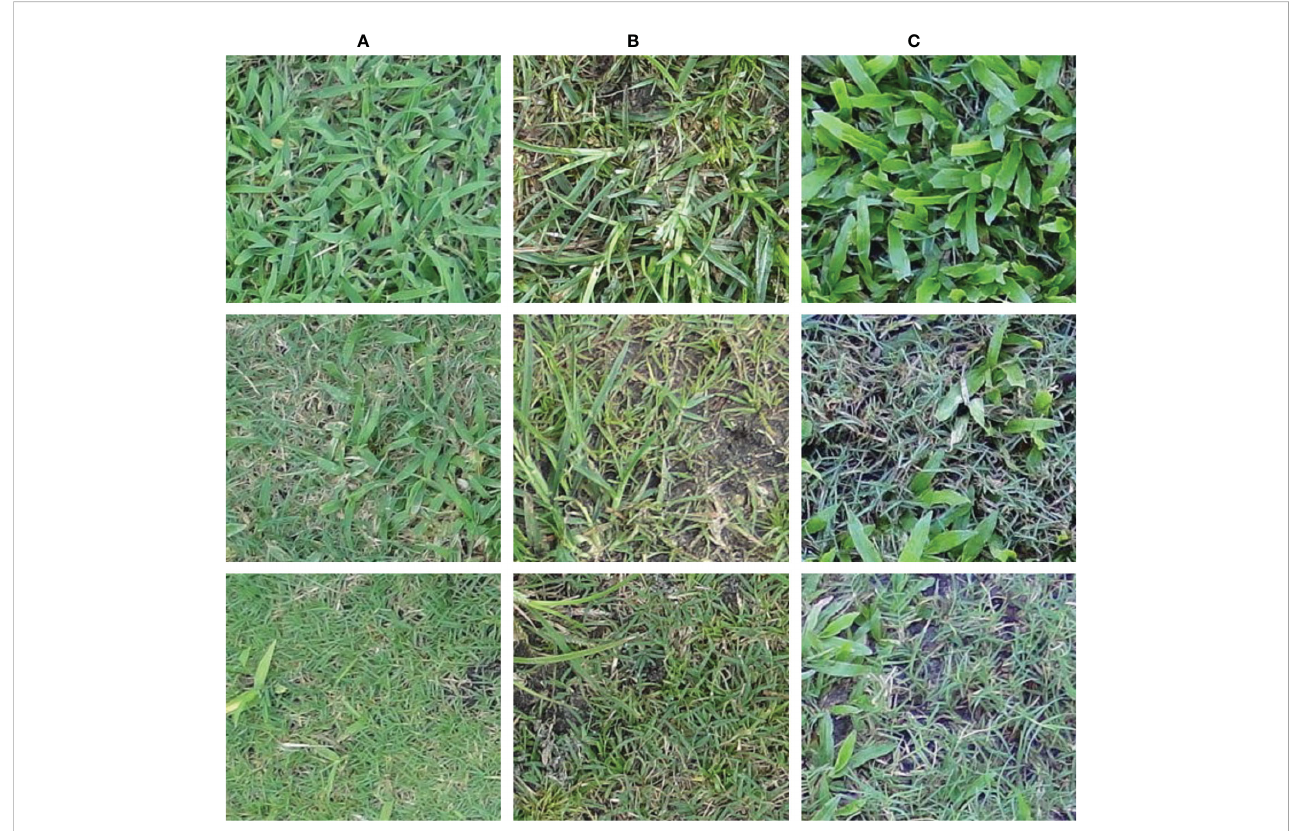
FIGURE 1 The training and testing sub-images of crabgrass (A) , goosegrass (B) , and tropical signalgrass (C) at different growth stages and